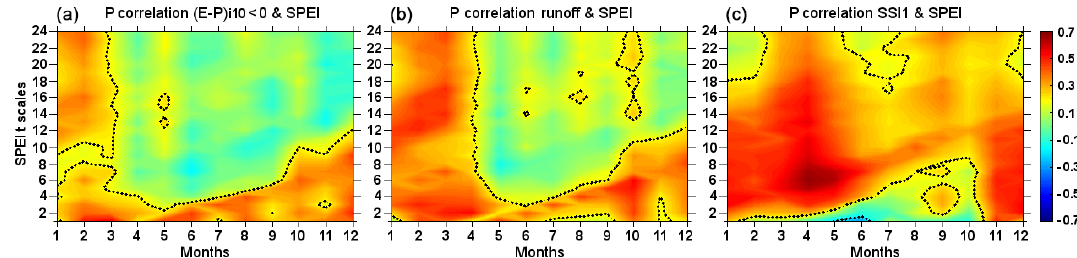
Figure 12. Monthly correlations among | ( E − P ) i 10 < 0 | (a) , runoff (b) , and SSI (c) from SPEI1 to SPEI24 in the Congo River basin. The dotted lines represent significant correlations at p< 0 . 05